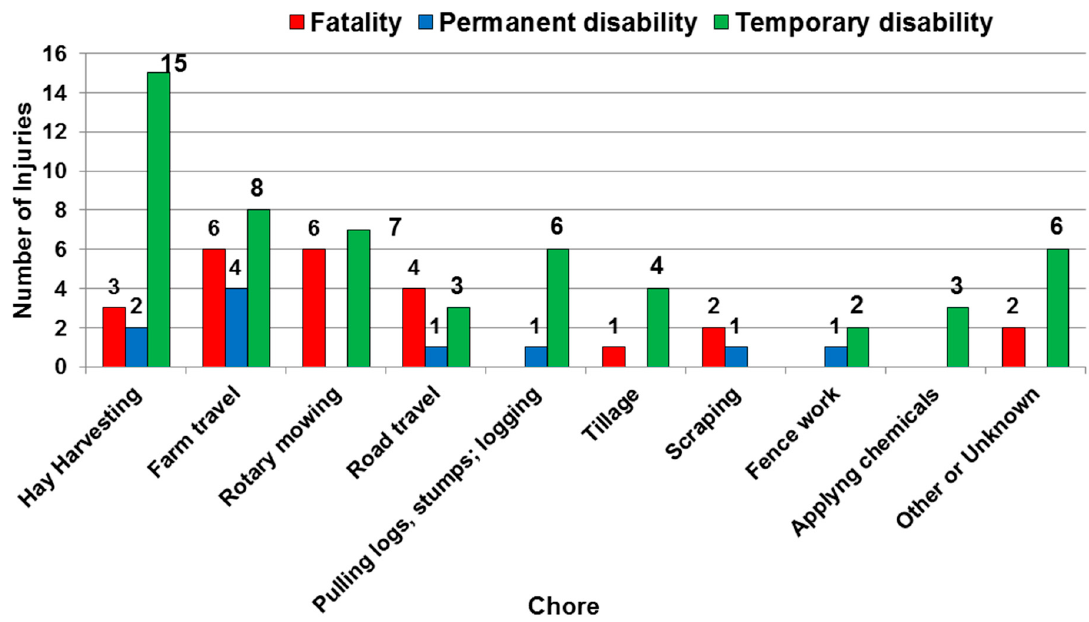
Figure 1. Number of fatal, permanent, or temporarily disabling injuries associated with overturns of tractors that lacked rollover protective structures in Kentucky,1960–2002, n = 88.